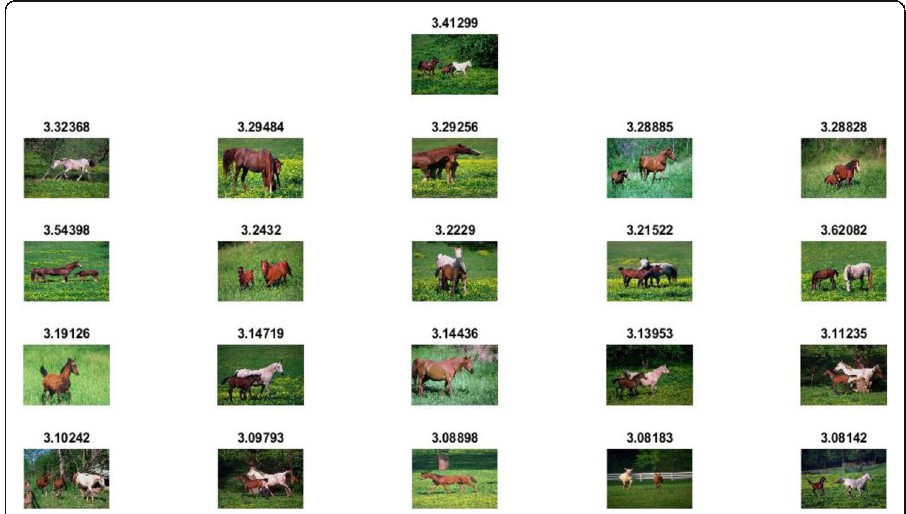
query image (first row)